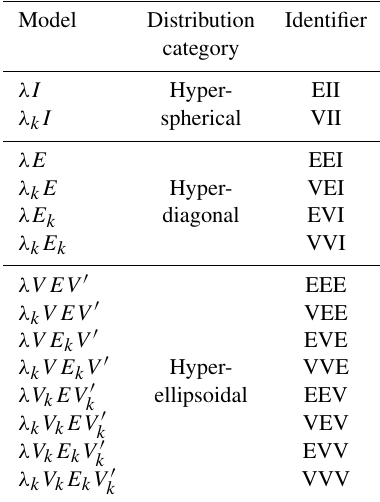
Table A1. The 14 covariance matrix